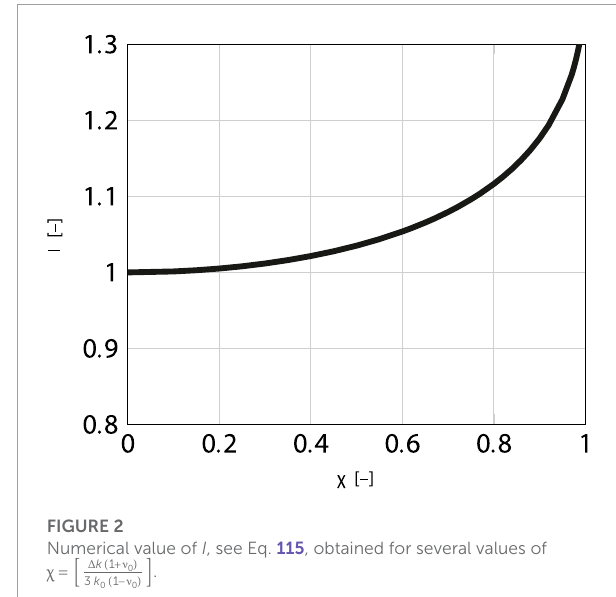
FIGURE 2 Numerical value of I , see Eq. 115 , obtained for several values